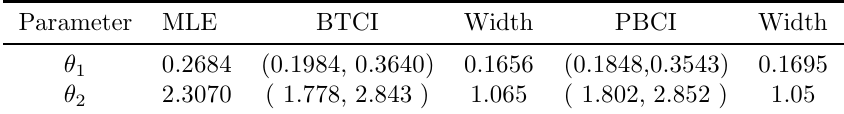
MLEs and Bootstrap CIs for real life